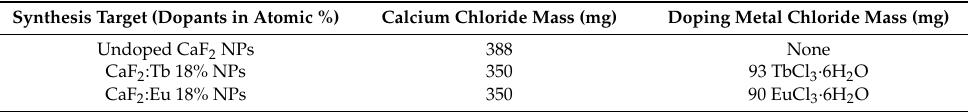
Table 1. Metal chloride masses added to flasks to attain certain doping amounts. Synthesis Target (Dopants in Atomic